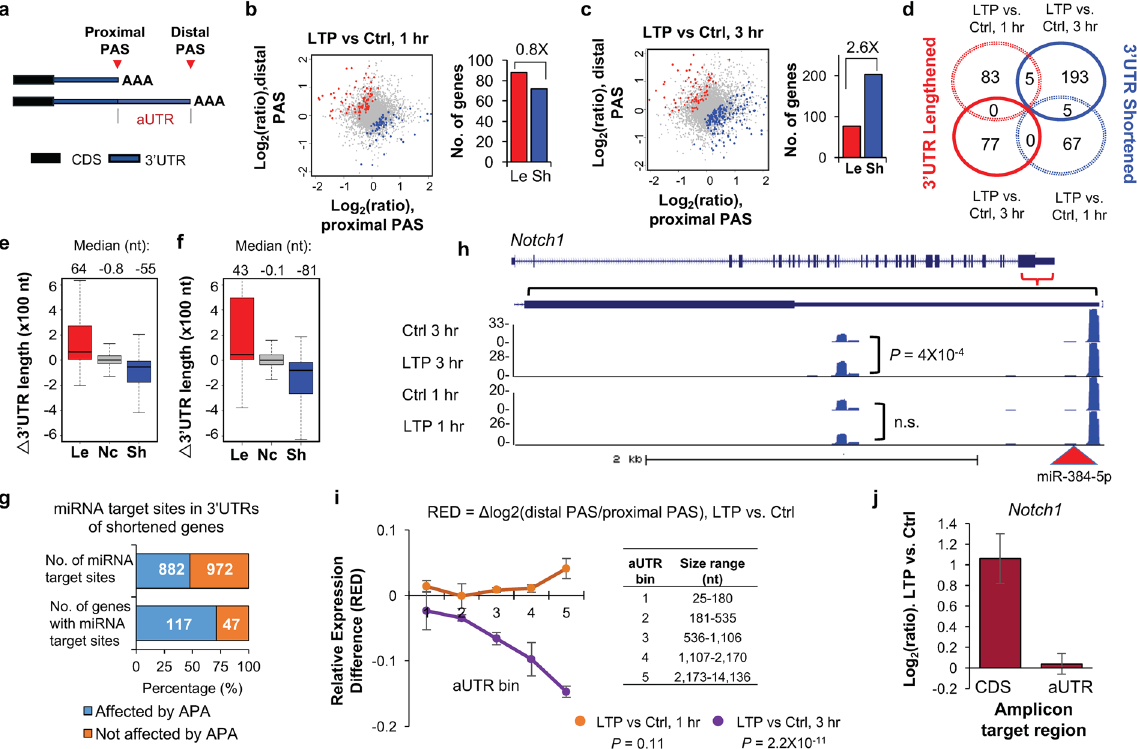
Figure 2. Regulation of 3 ′ UTR APA after LTP induction. ( a ) Schematic of 3 ′ UTR APA. ( b ) 3 ′ UTR APA regulation after 1 hr LTP induction. Left, Scatterplot comparing expression changes of proximal and distal PASs after 1 hr LTP induction. Genes that significantly switched to proximal PAS usage are in blue and those that switched to distal PAS usage are in red (P < 0.05, DEXSeq, and relative abundance change > 5%). Grey dots are genes without significant APA regulation. Right, bar graph comparing the number of genes with lengthened or shortened 3 ′ UTRs (Le and Sh, respectively). ( c ) As in ( b ), 3 hr post LTP induction. ( d ) Venn diagram comparing genes with significant 3 ′ UTR regulation 1 hr post LTP induction and 3 hr post LTP induction. ( e ) 3 ′ UTR length change in 1 hr post LTP induction. Genes with 3 ′ UTRs significantly shortened (blue), lengthened (red), or unchanged (grey) are shown. 3 ′ UTR size was based on weighted mean of all 3 ′ UTR isoforms. Median values are indicated on the top. ( f ) As in ( e ), except that data are based on 3 hr post LTP induction. ( g ) Effect of 3 ′ UTR shortening on miRNA targeting. Number of miRNA target sites that are removed (882) or not removed (972) by 3 ′ UTR shortening is indicated in the upper bar, and number of genes that contain removed (117) or not removed (47) miRNA target sites by 3 ′ UTR shortening are indicated in lower bar. ( h ) An example gene Notch1 , which displayed 3 ′ UTR shortening after LTP. UCSC genome browser tracks of 3 ′ READS data are shown. Gene structure and 3 ′ UTR sequence are indicated on top. Peaks from two polyA sites indicate reads for corresponding APA isoforms. miR-384-5p target site is indicated. Reads are based on combined samples. ( i ) Relationship between aUTR size and 3 ′ UTR-APA regulation at 1 hr or 3 hr post LTP induction. Relative expression difference (RED) was calculated for all genes with APA sites. The formula of RED is indicated above the graph. Genes were divided into five groups (aUTR bins, listed on the right) based on aUTR size, with approximately equal number of genes in each bin. For each bin, mean RED was calculated. Error bars are standard error of mean (SEM). P-value (Wilcoxon rank sum test) indicates the difference between bin 1 and bin 5. ( j ) RT-qPCR validation of Notch1 APA regulation. Two different primer sets were used to detect the expression of a common coding region (left bar) and a region in the alternative 3 ′ UTR (right bar). Error bars are SEM of 4